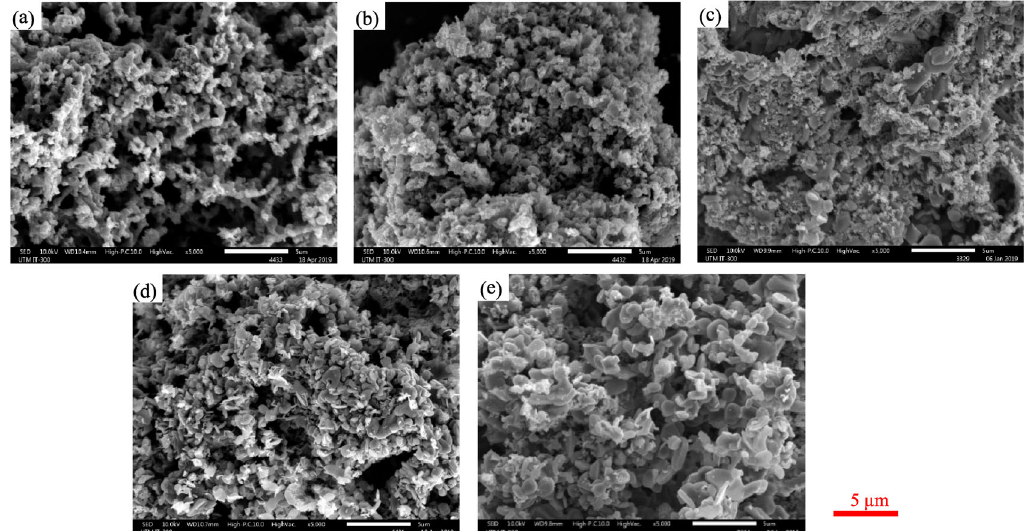
Fig. 3 VP-SEM micrographs of black powder (a) before calcination; after calcination for 4 h at (b) 773, (c) 873, (d) 973, and (e) 1073